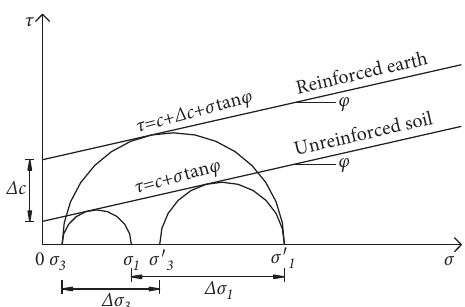
Figure 2: Diagram of the strength analysis of reinforced